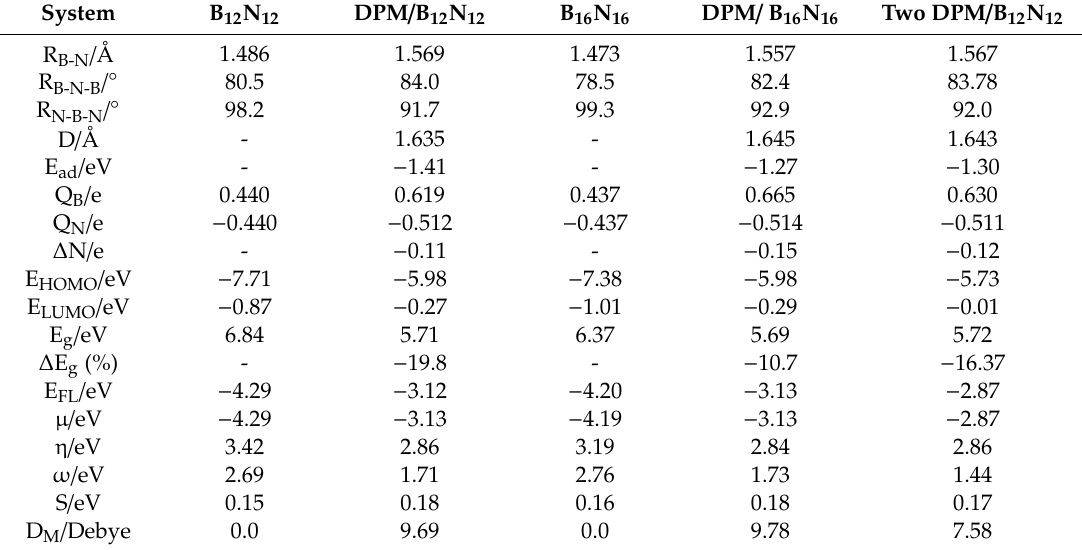
Table 1. Calculated adsorption energy (E ad ), charge (e), HOMO and LUMO energies (E HOMO and E LUMO ), Fermi level energies (E F ), energy gap (E g ), dipole moment (D M ), and quantum